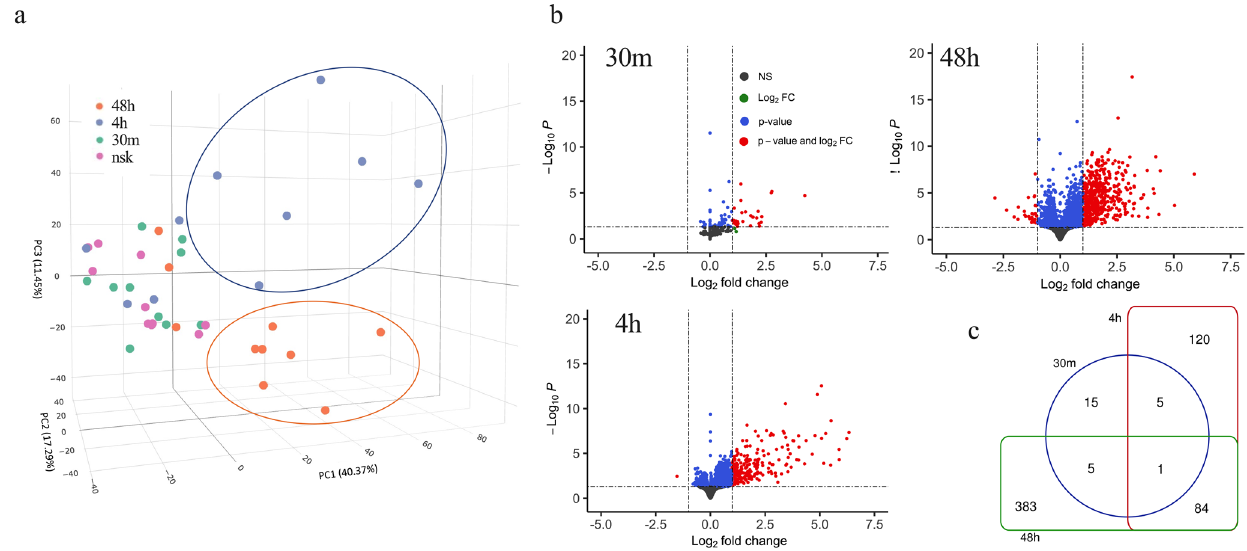
Fig. 3 | Differential expression gene (DEG) induced by Aedes aegypti mosquito bites over time. a 3D principal component analysis showing clustering of indivi- dualbiopsiestakenat30min(greendots),4h(bluedots),48h(orangedots)post- bite or normal skin (NSK; pink dots). Blue ellipse indicates clustering at 4h, while orange ellipse at 48h. b Volcano plot comparing DEG from skin biopsies post-bite